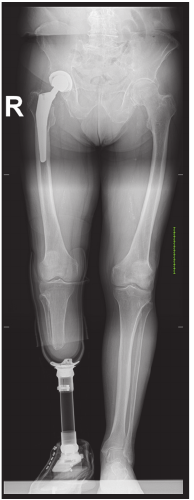
Figure 2: Anterior-posterior X-ray pelvis: displaced neck of femur fracture (right).